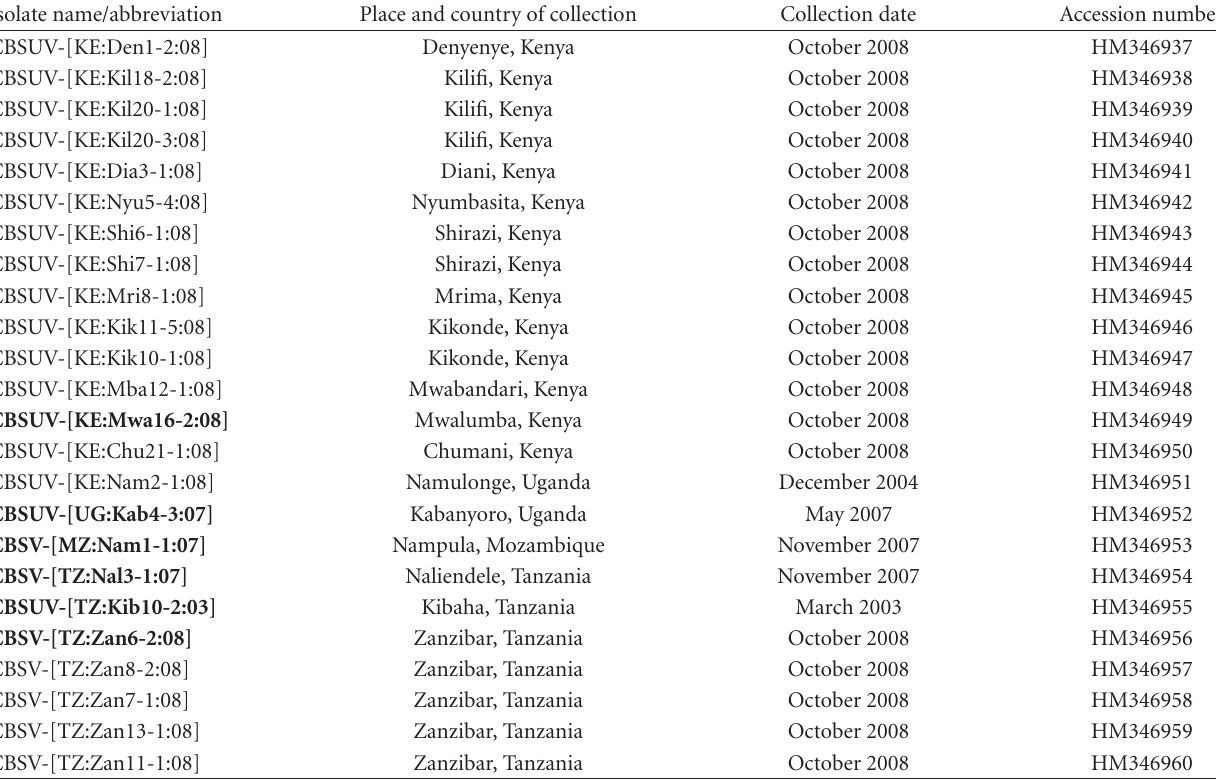
Table 1: List of CBSD isolates sequenced in this study; those used in the symptom diversity study are in bold. Isolate